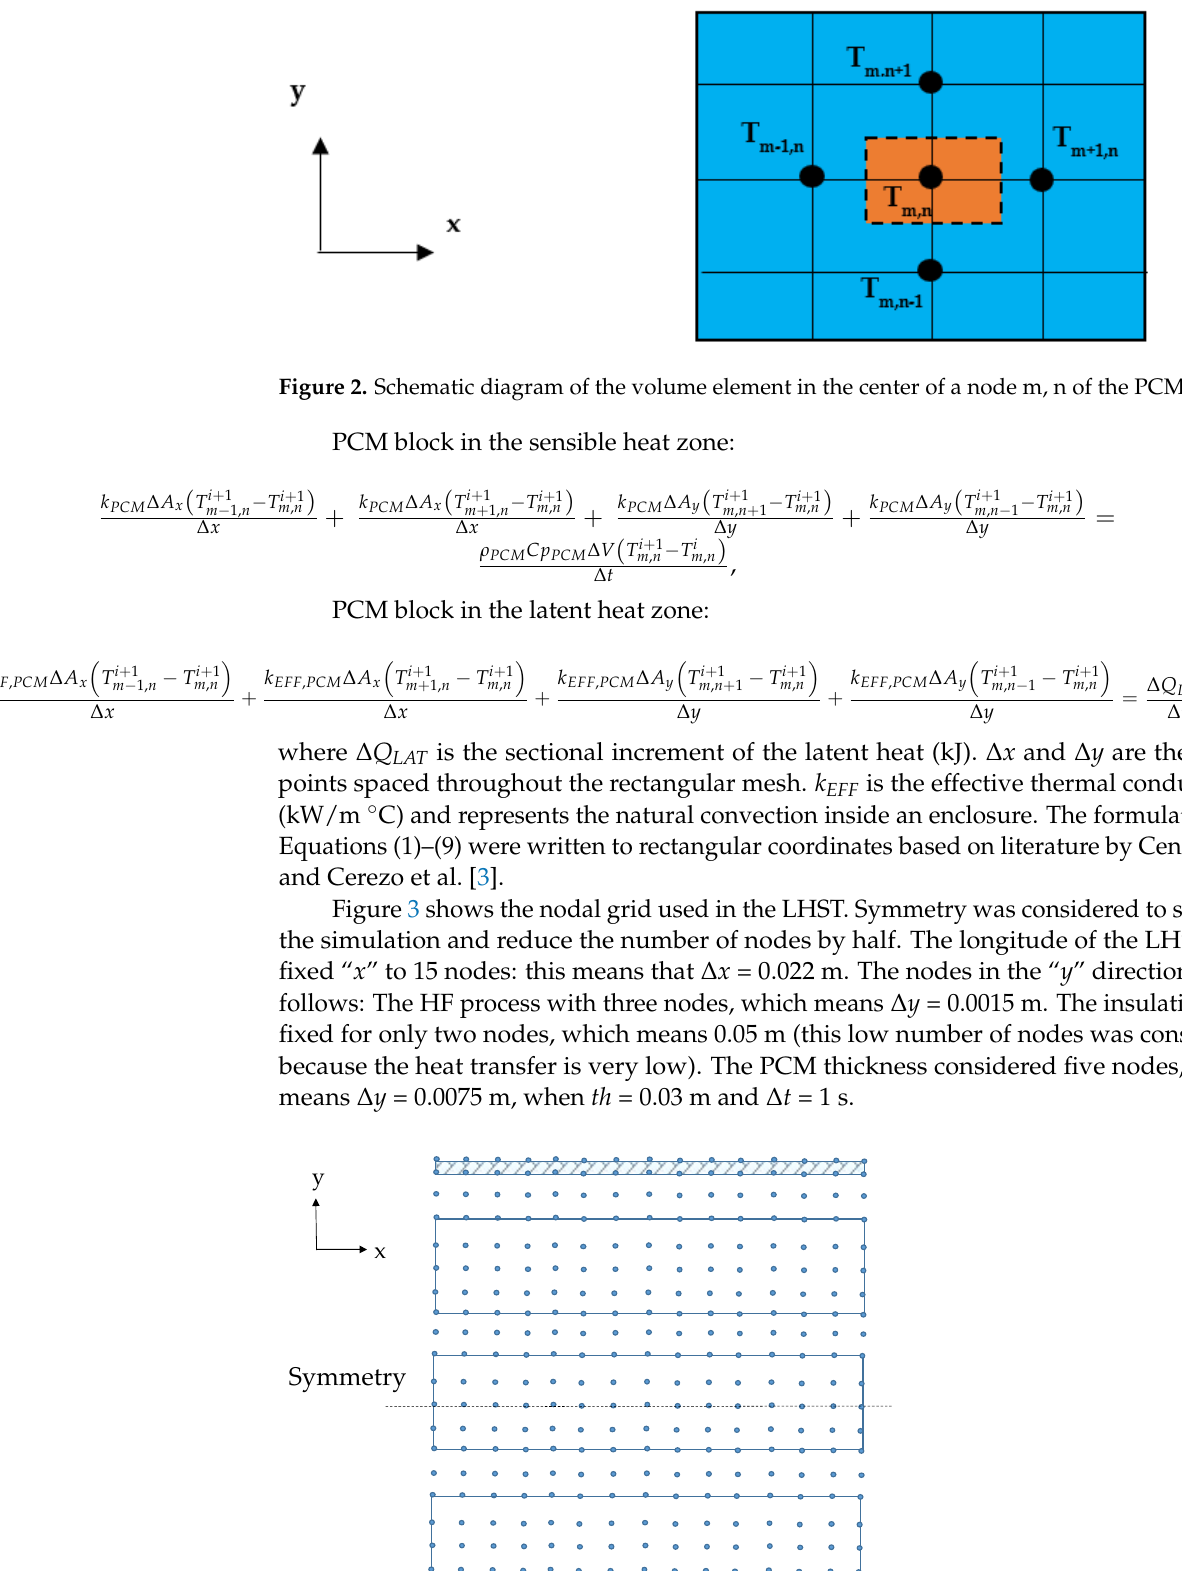
Symmetry Symmetry